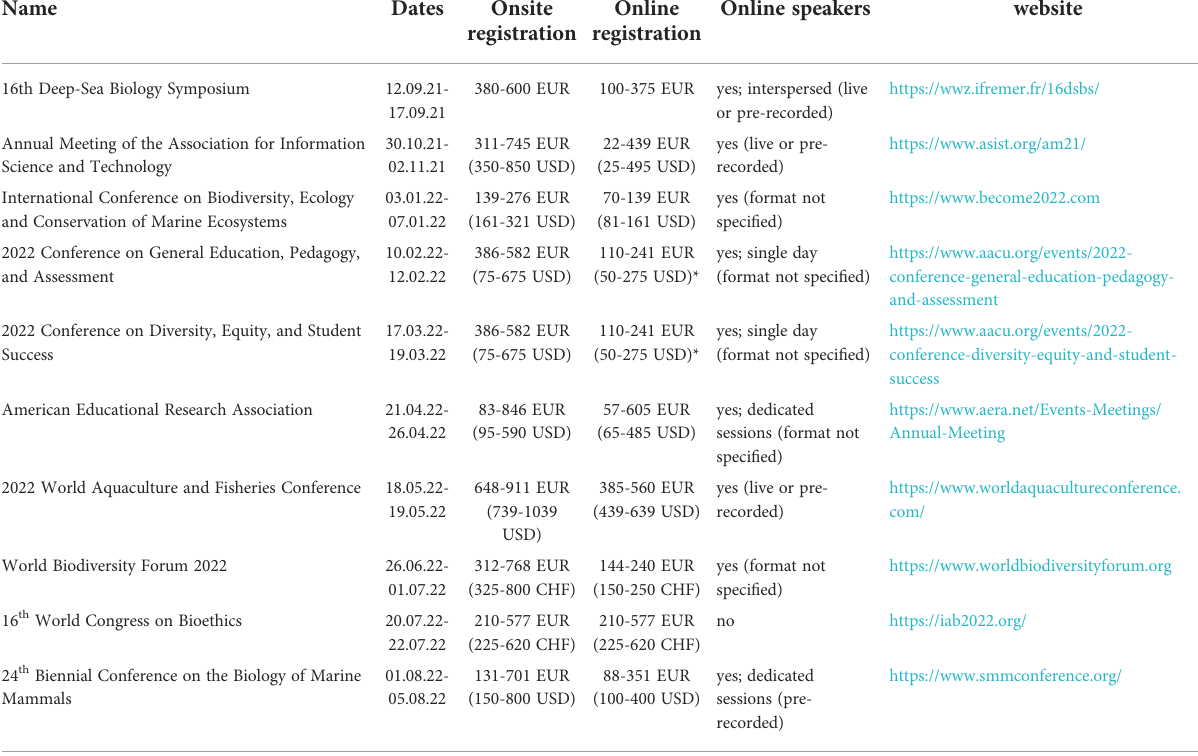
TABLE 2 Non-exhaustive examples of registration fees for 2021-2022 hybrid